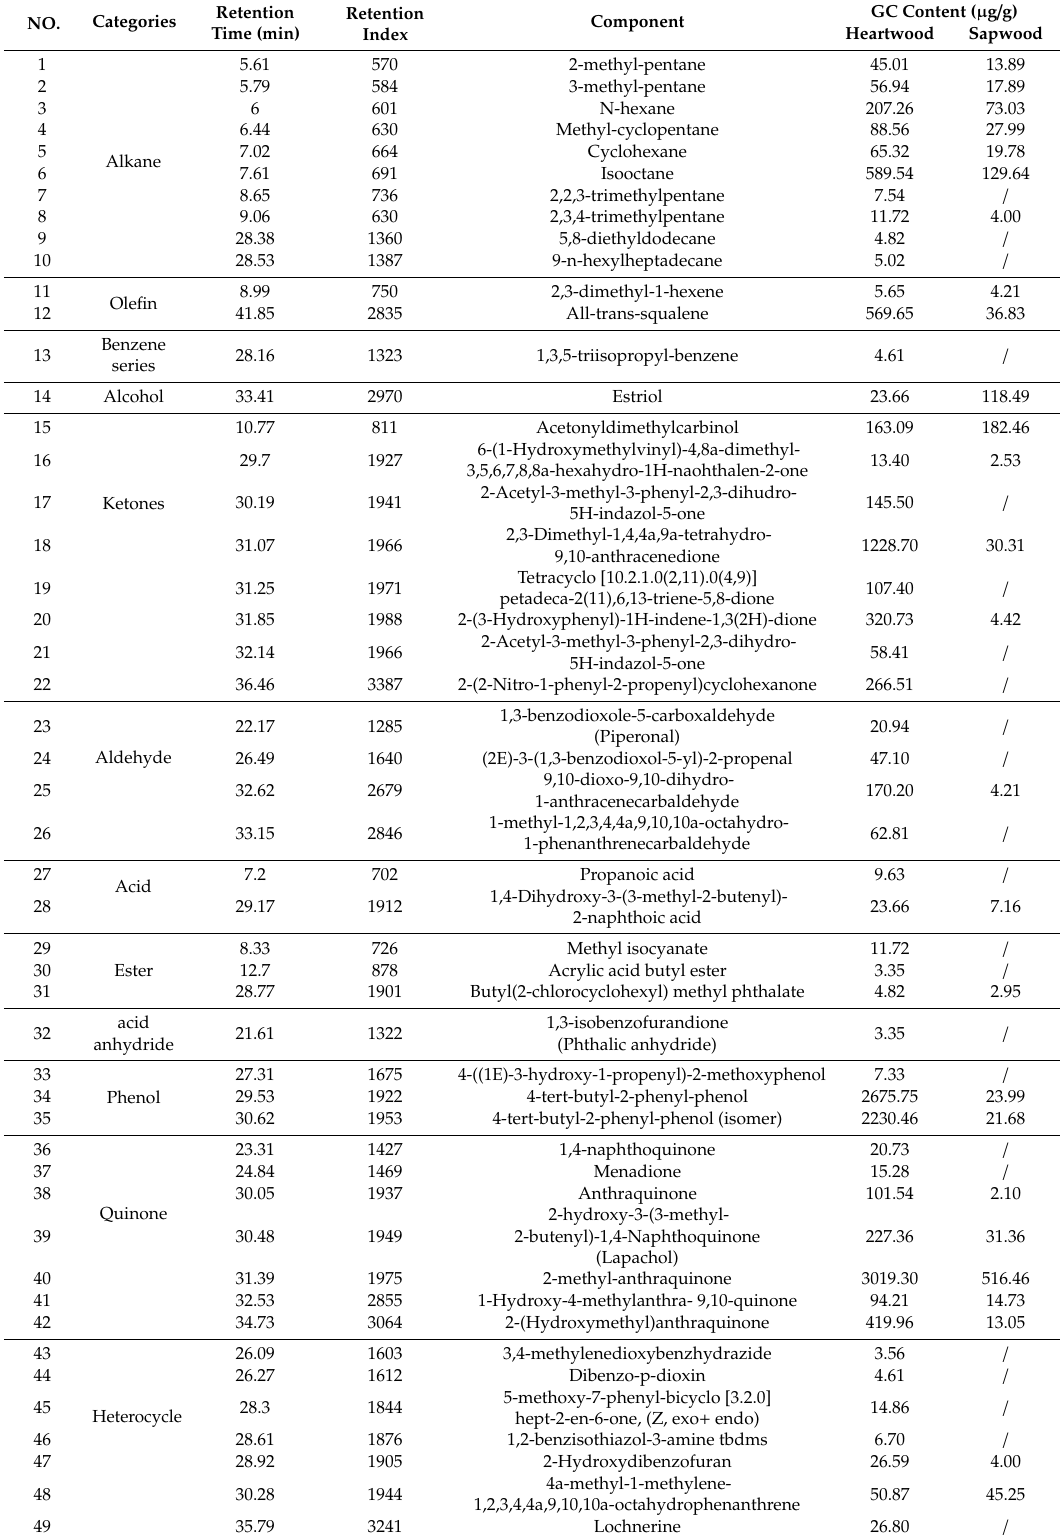
Table 4. GC–MS analytical results of acetone extractive compounds in heartwood and sapwood of teak.